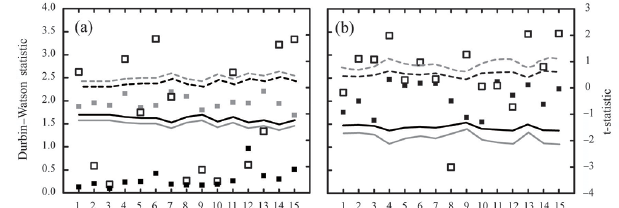
Figure 7. Statistic tests for the integral approach (a) and slope– area analysis (b) . Black hollow squares are t statistic of Spear- man rank correlation coefficient. Black solid squares are Durbin– Watson statistics. The gray solid line, black solid line, black dashed line and gray dashed line are D L , D U , 4-D U , and 4-D L . Gray squares in (a) are the Durbin–Watson statistics of revised χ − z plots. The numbers 1 to 15 indicate streams, in the following or- der: Singley, Davis, Fourmile, Cooskie, Randall, Oat, Kinsey, Big, Shipman, Buck, Horse Mtn, Hardy, Juan, Howard, and